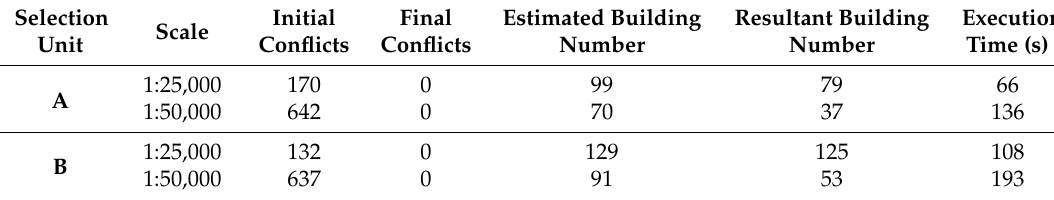
Figure 21. Test results of selection unit B: ( a ) visual reduction without selection (1:50,000), ( b ) selection result using the GA (1:50,000), and ( c ) selection result enlarged to 1:10,000 from 1:50,000. Table 1. Statistical analysis of the GA results.